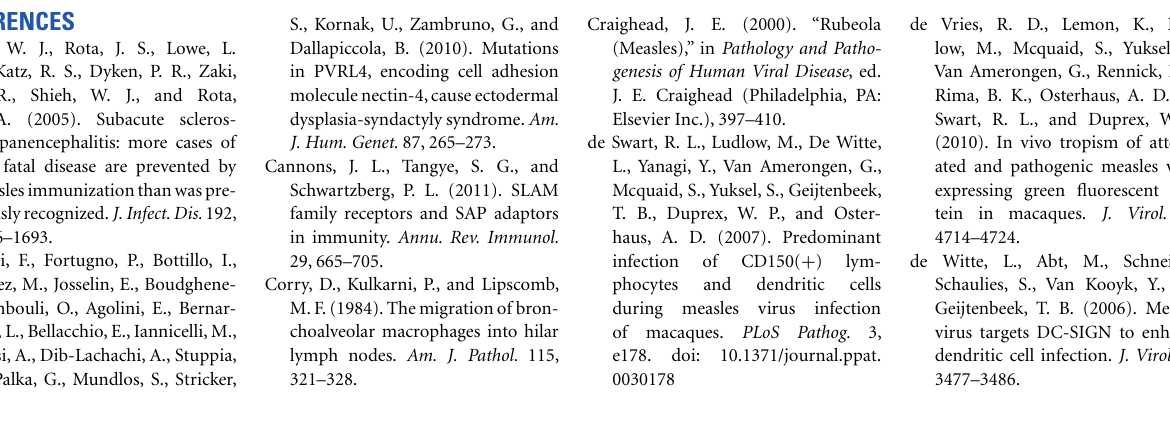
FIGURE 3 | Pathology of measles. MV initiates its infection via SLAM-mediated entry into alveolar macrophages and DCs in the lung. After initial replication in regional lymph nodes, MV enters the bloodstream and subsequently spreads to all lymphoid organs, such as the spleen, thymus, appendix, tonsil, and lymph nodes, throughout the body.When the MV